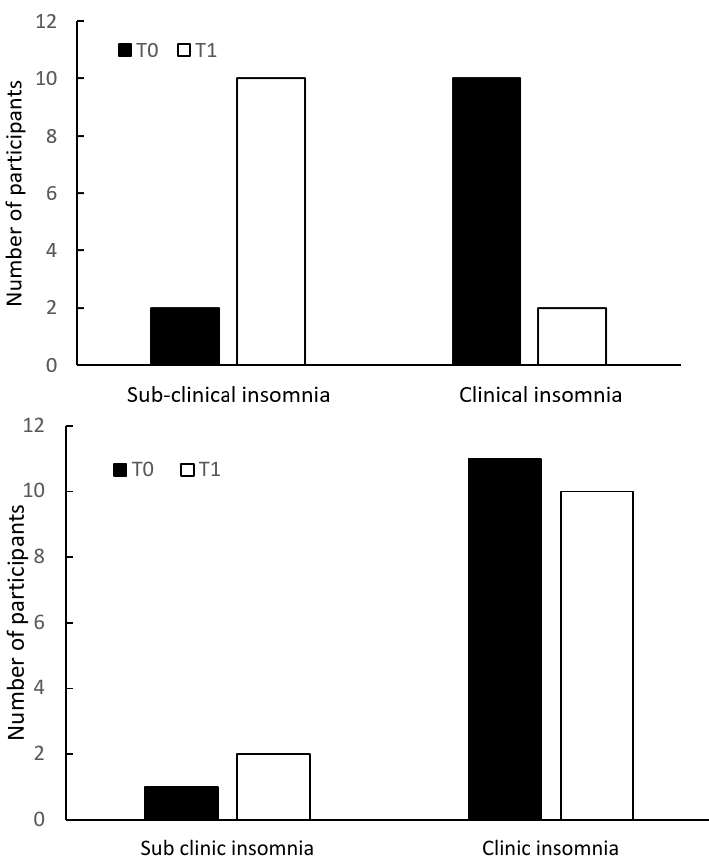
Figure 1. Insomnia Severity Index (ISI) categories at T0 and T1, in the intervention group ( above ) and in the control group ( below ).